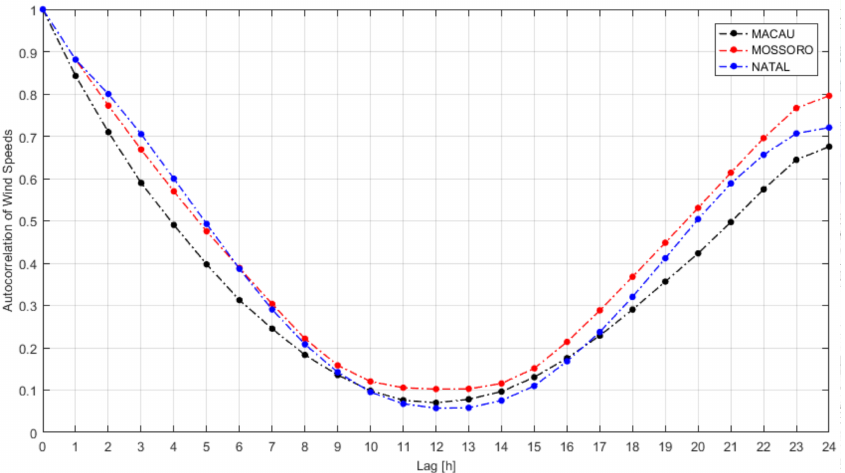
Figure 6. Autocorrelation of the wind